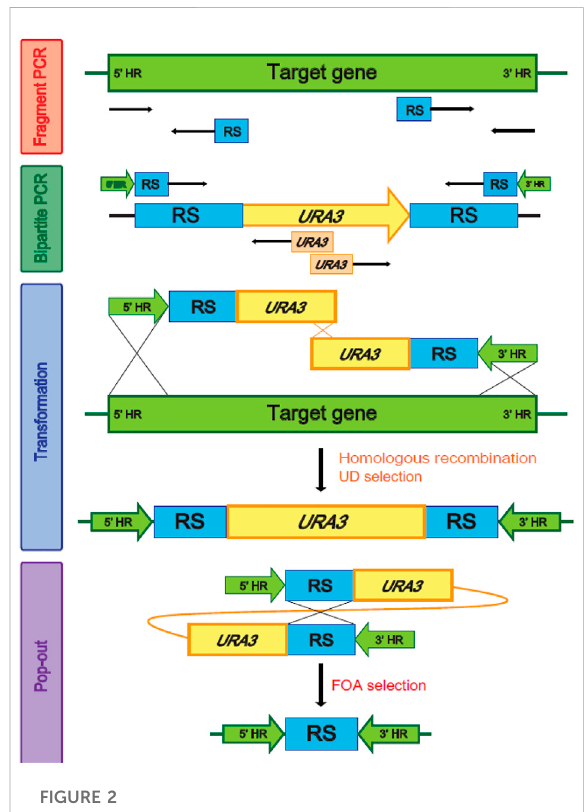
FIGURE 2 Homologous recombination and the 5-FOA